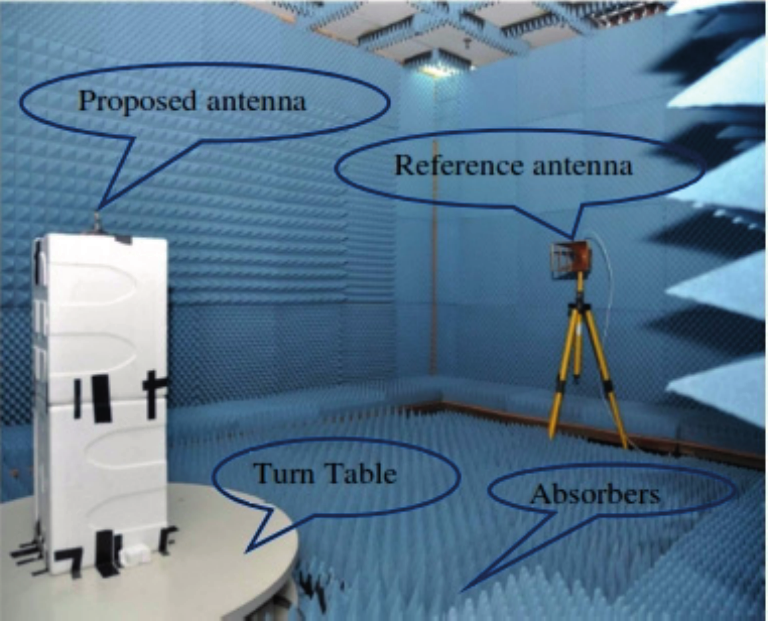
Figure 12. The anechoic chamber for the proposed UWB antenna.